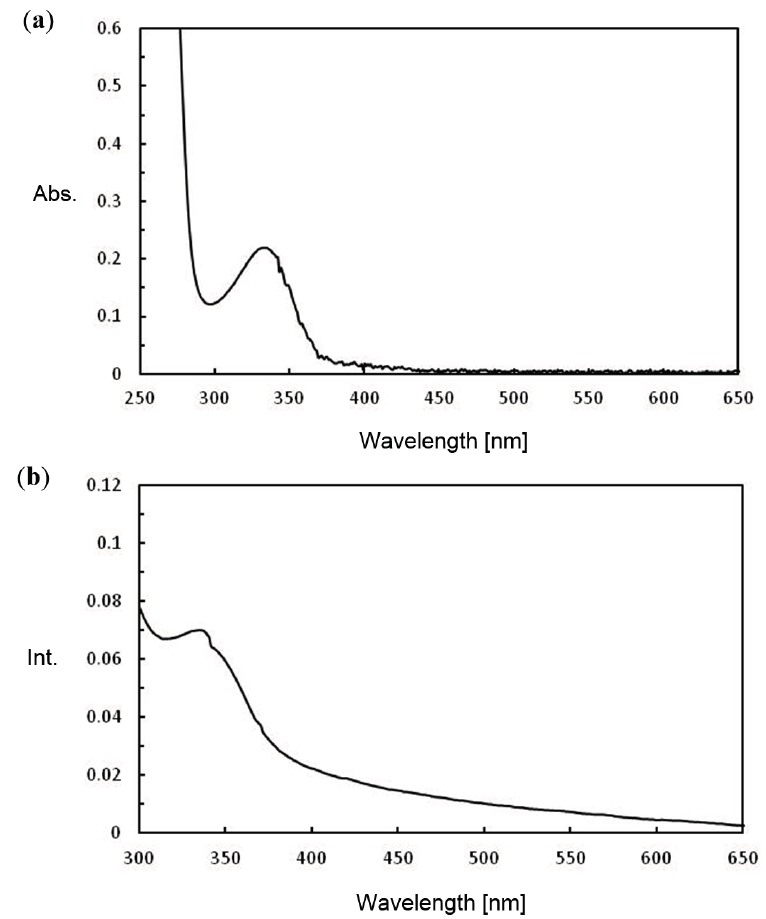
Figure 4. UV-vis. spectra of 7 ( a ) in acetonitrile (2.0 × 10 − 3 M); ( b ) casted onto Pyrex slide